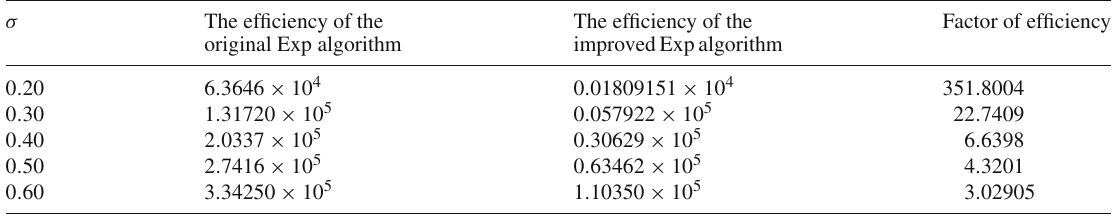
Table 3 The efficiency of simulation algorithms as (simulated variance × CPU time) for the up-and-out put barrier option under the CEV model with β = 0, M = 10 6 and (cid:7) t = E [ δ t ] = 0 . 002 σ The efficiency of the The efficiency of the Factor of efficiency original Exp algorithm improvedExp algorithm